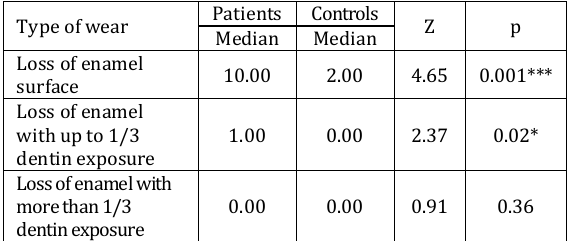
Table 4. Wear of teeth in the studied groups expressed by